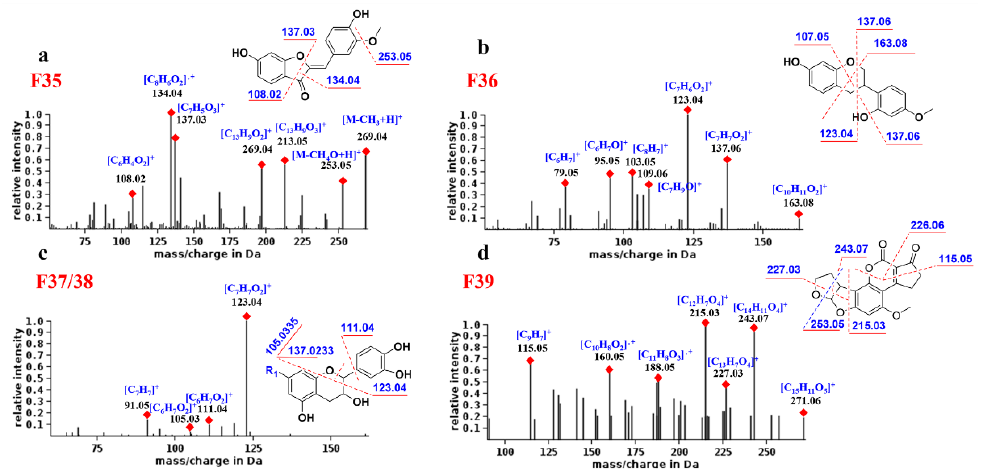
Figure 6. Proposed fragmentation pathways and fragments annotation of F 35 –F 39 . ( a ) F 35 ; ( b ) F 36 ; ( c ) F 37 and F 38 ; ( d ) F 39